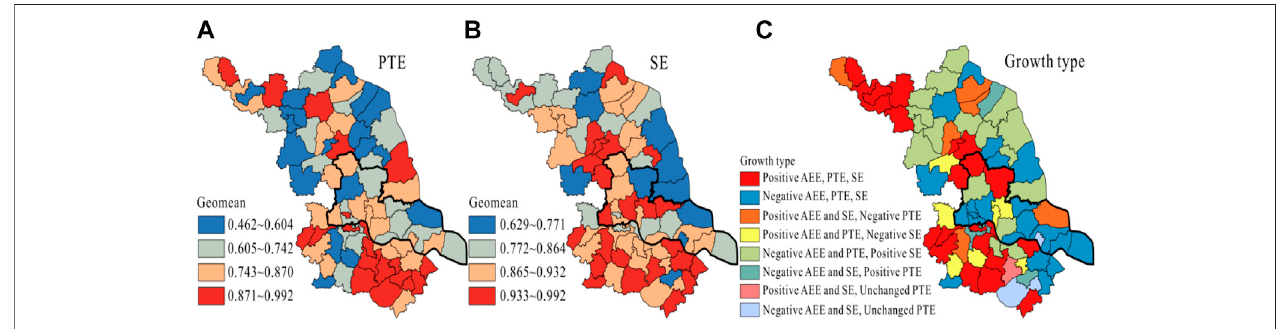
FIGURE 6 | The growth type of between agricultural eco-ef fi ciency, pure technology ef fi ciency, and scale ef fi ciency.